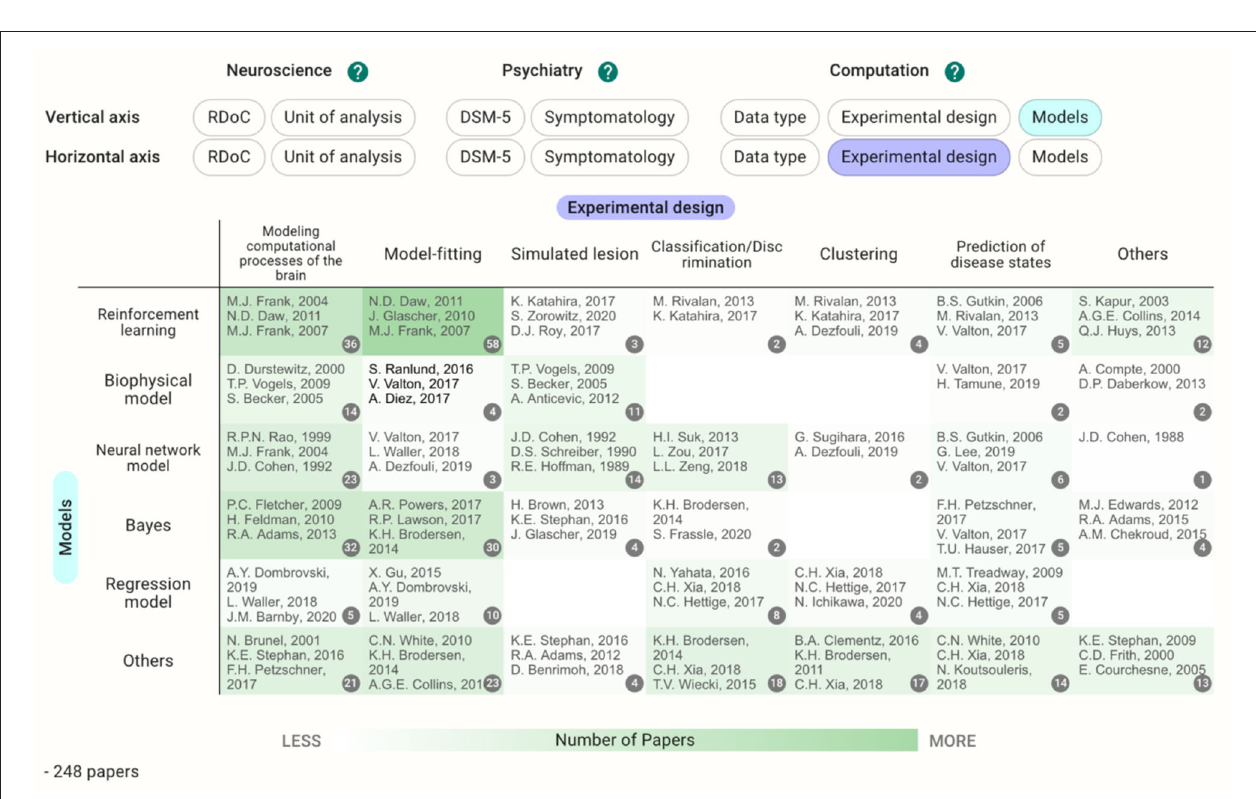
some extent, showing the variety of the methodology in the